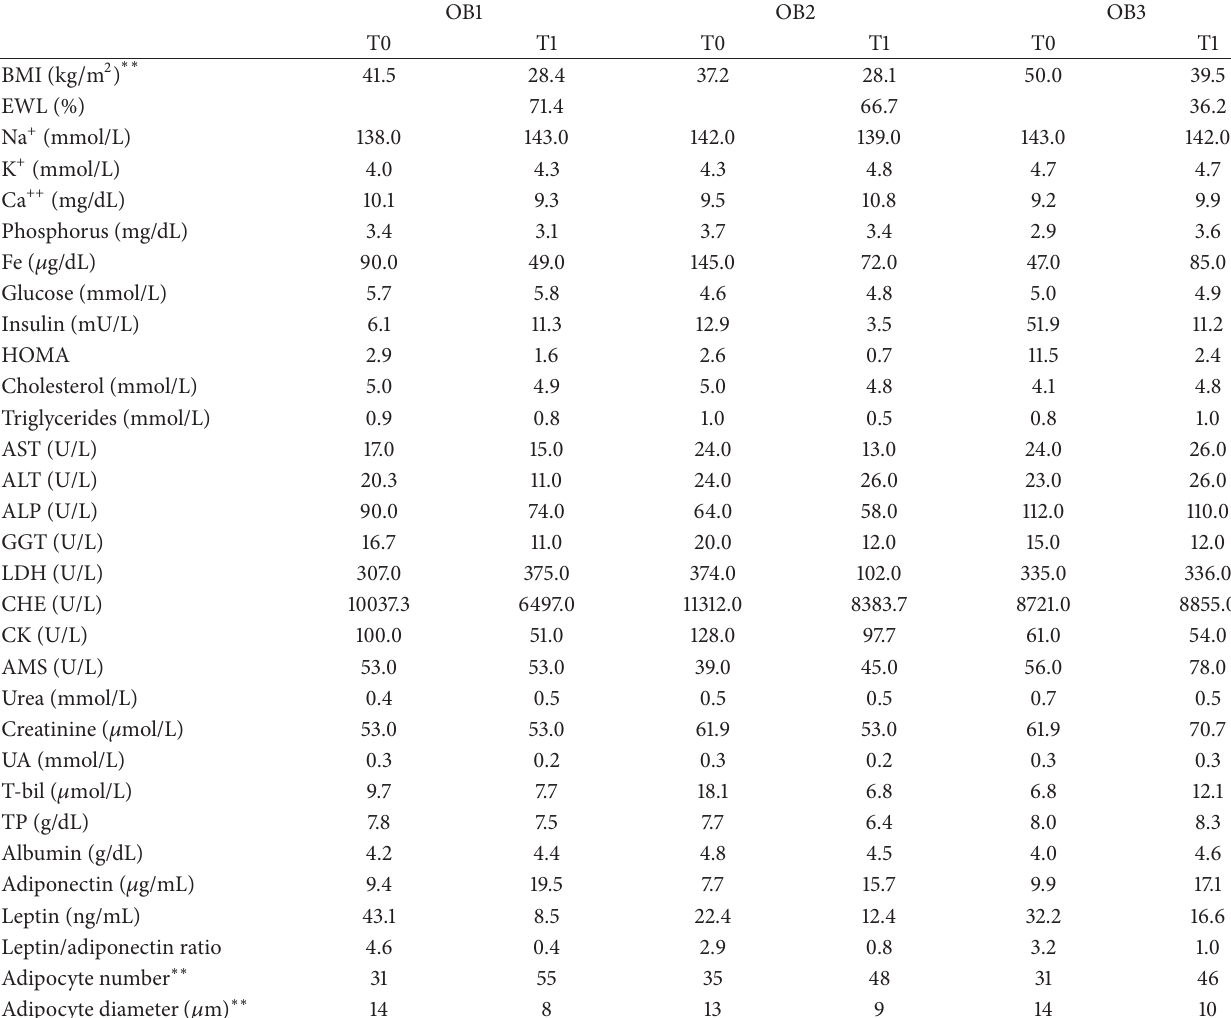
Table 1: Clinical and biochemical parameters measured in three obese females (OB) before (T0) and three years after LAGB (T1). ∗